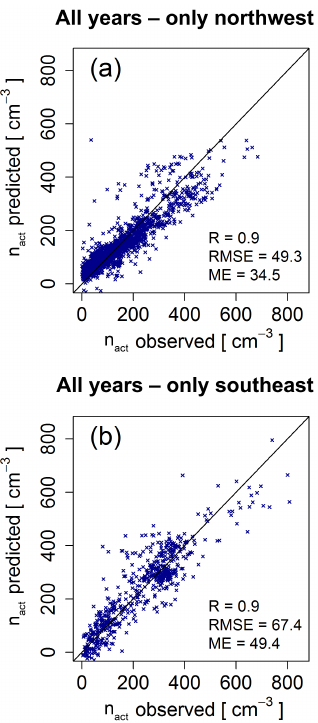
Figure 8. The modelled number of cloud droplets (Eq. 5) plotted against the observed number of residuals. Only data for northwest- ern wind conditions are included in (a) , while only data for south- eastern wind directions are included in (b) .